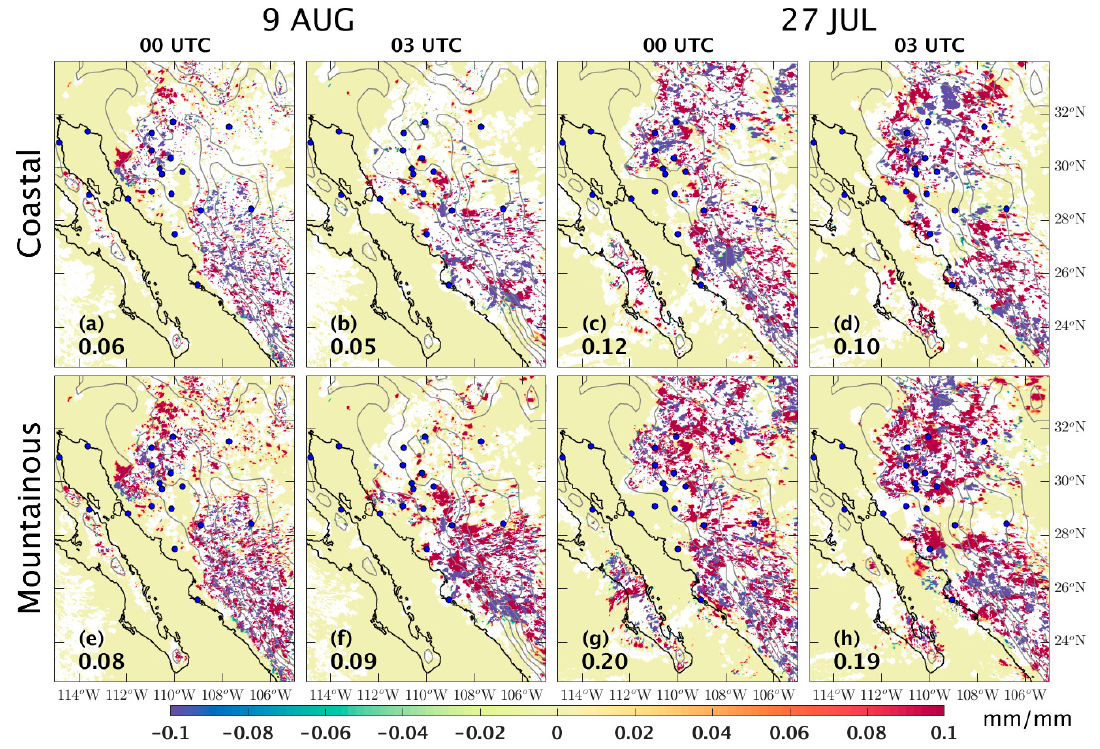
Figure 11. This figure shows the mean hourly sensitivity of WRF-GFS precipitation across the domain, relative to the WRF-GFS-equivalent initial PWV in the coastal and mountainous sites, at 0000 UTC and 0300 UTC for both weakly ( a , b , e , f ) and strongly ( c , d , g , h ) forced days. Only statistically significant correlations (p < 0.05) are displayed. The mean of the absolute values across the domain is shown on the lower left of each panel. The mountainous sites exhibit higher values than the coastal sites on both weakly and strongly forced days.